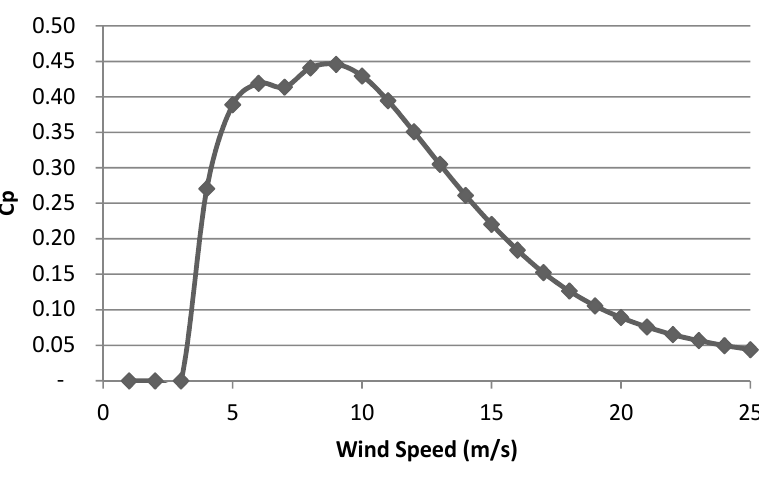
Figure 8. WTG power coefficient C p